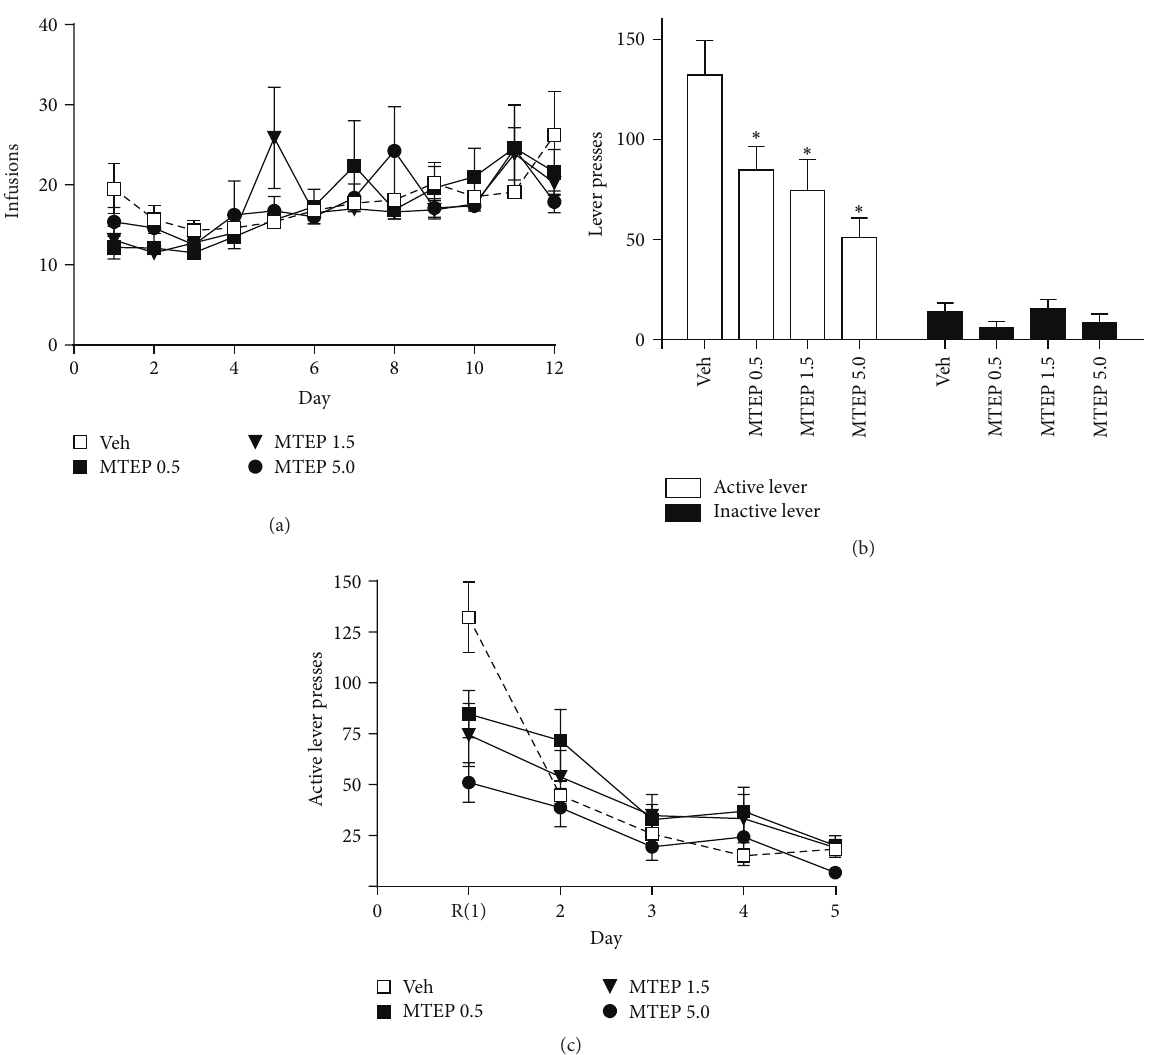
Figure 1: Systemic administration of MTEP attenuates context-primed relapse following abstinence and extinction learning. (a) Mean infusions during the self-administration period did not differ between groups later given MTEP or vehicle during the relapse test. (b) MTEP (0.5–5 mg/kg i.p.) significantly decreased responding on the previously active lever while not affecting inactive lever pressing. (c) Administration of MTEP prior to relapse test (R, extinction day 1) did not significantly alter extinction responding on the following days (no group differences on days 2–5). ∗ 𝑝 < 0.05 compared to